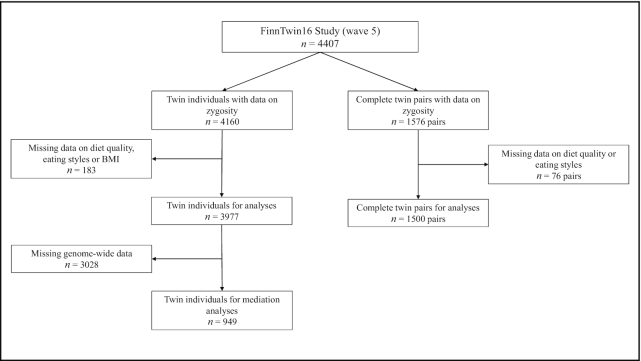
Flowchart diagram of participants’ selection.